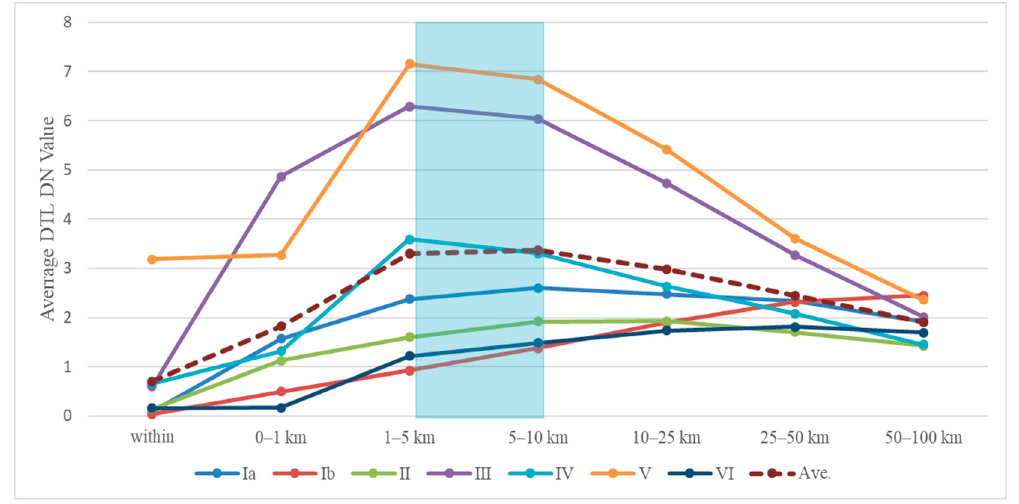
Figure 9. The NTL level of different types of PAs in their interior and surrounding buffer zones. The blue shadowed area represents the fact that the 1–10 km buffer zone had the highest NTL level.